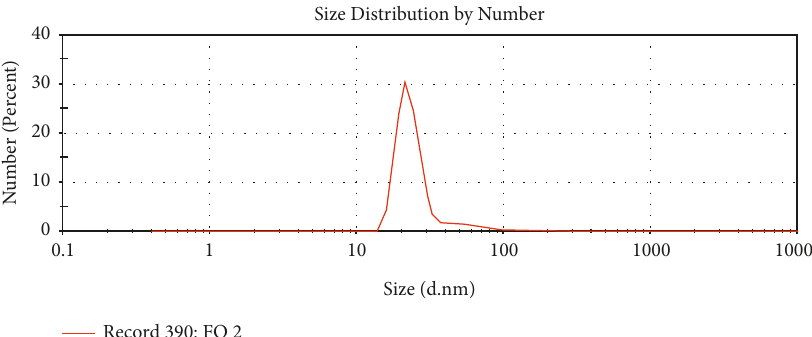
Figure 2: Particle size distribution of the nanocomposite adsorbent (BMNC).